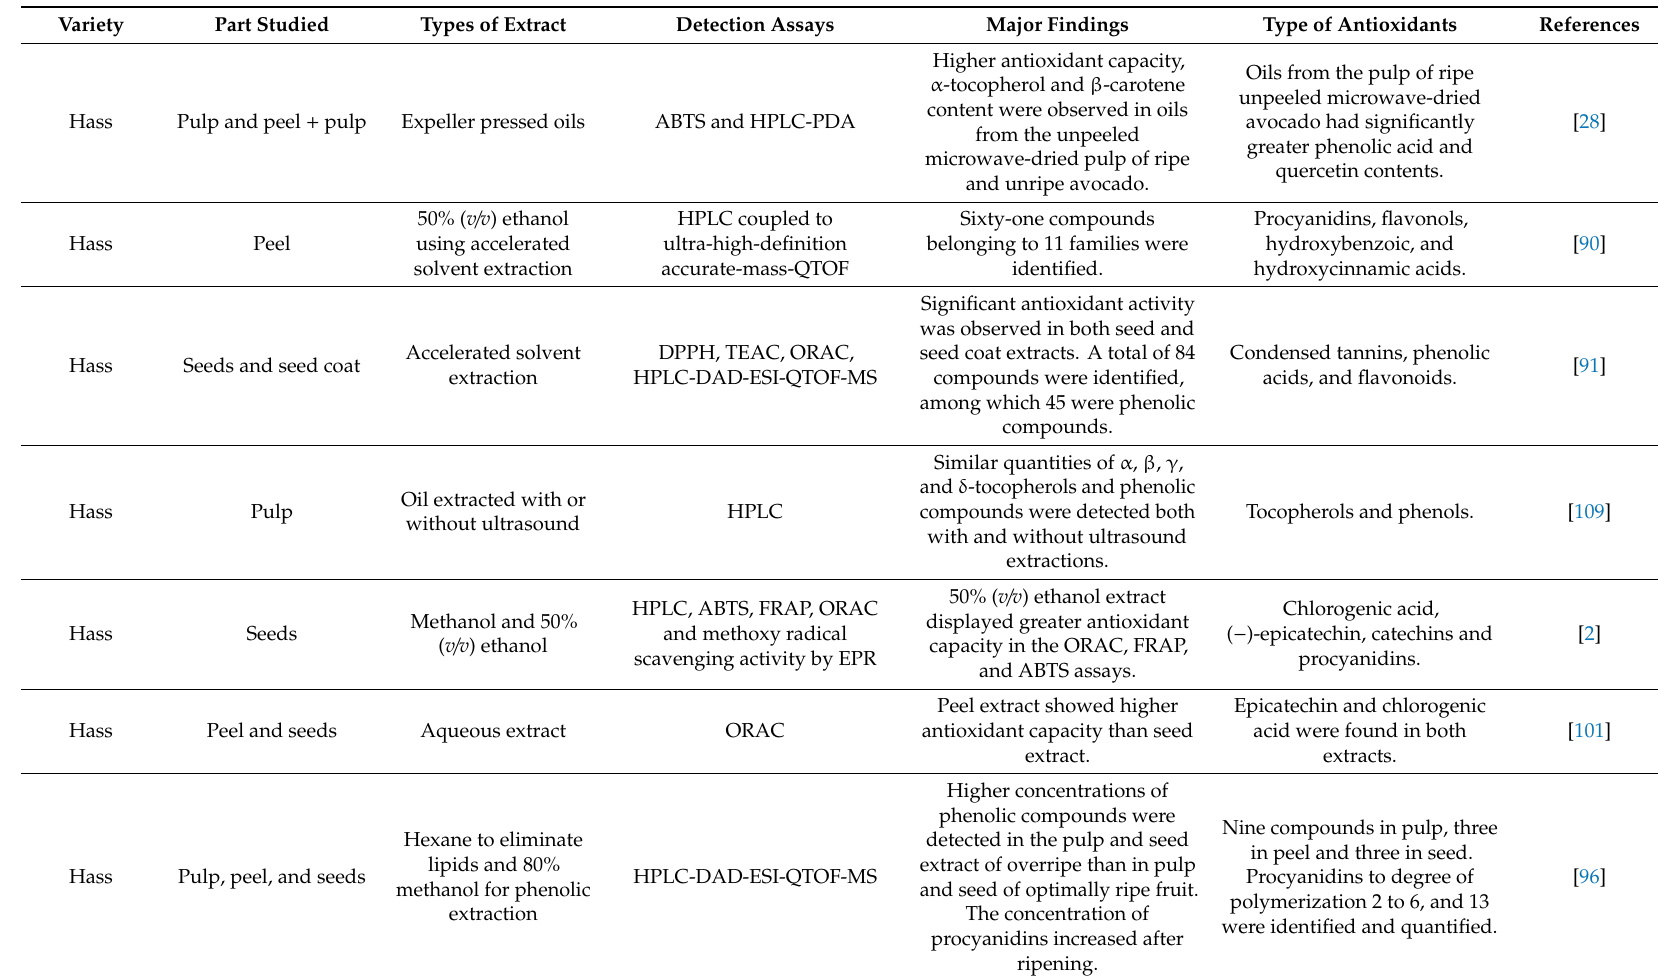
Table 3. Antioxidant properties of Persea Americana